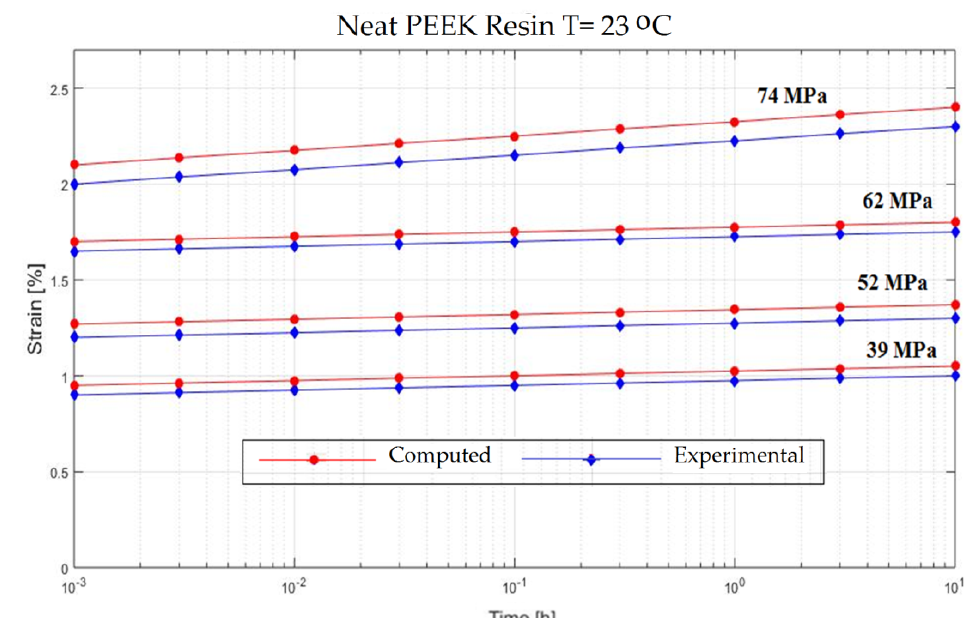
Figure 7. Creep response of a carbon/epoxy {90} 4s at T = 100 ◦ C.